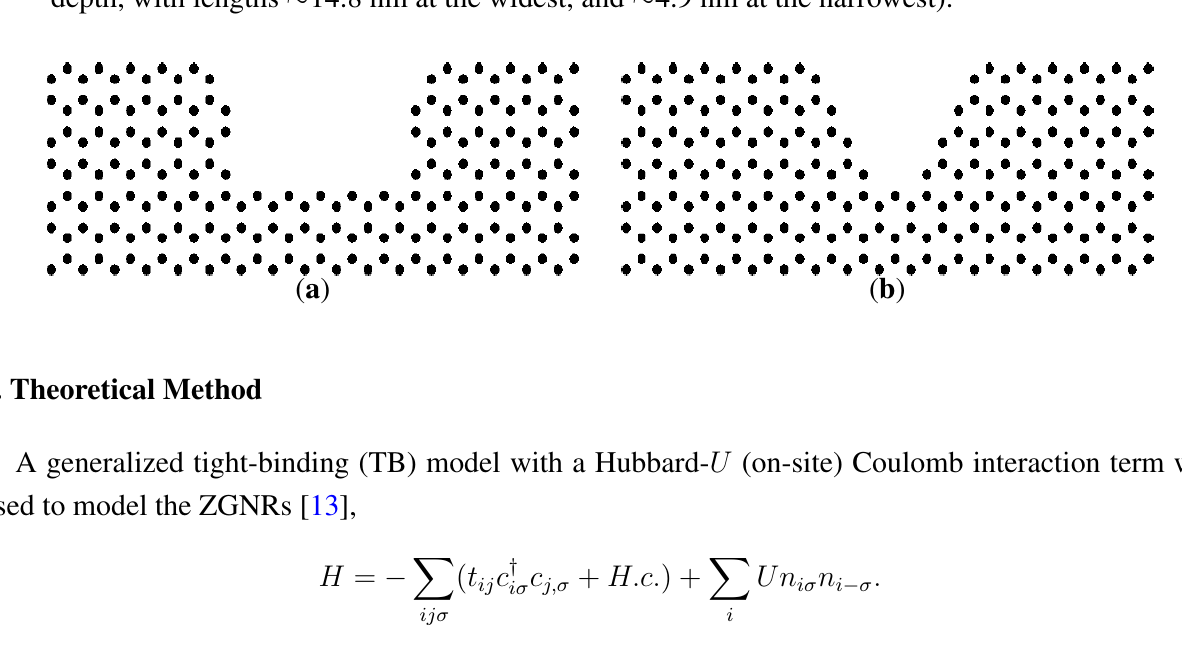
Figure 1. An unstrained ZGNR device (ribbon dimensions ∼ 40.6 nm × 13.5 nm) with an asymmetric ( a ) square notch ( ∼ 14.8 nm × 8.53 nm); and ( b ) V-shaped notch ( ∼ 8.53 nm depth, with lengths ∼ 14.8 nm at the widest, and ∼ 4.9 nm at the